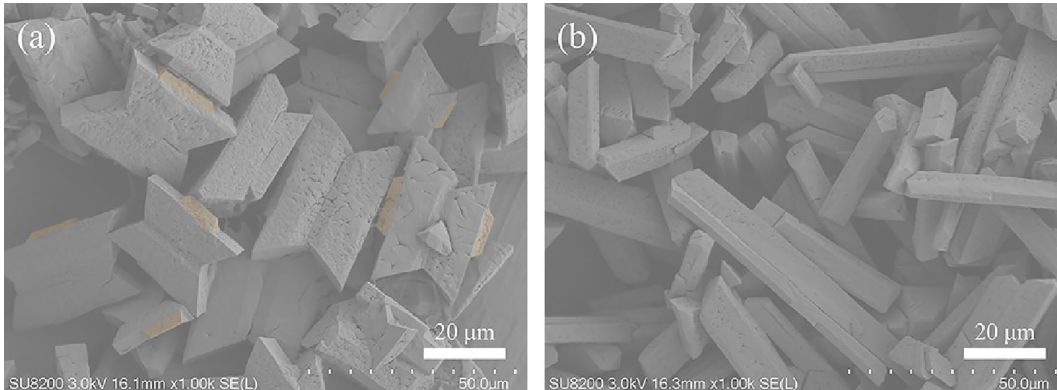
Figure 4. FESEM images of the samples biomimetically synthesized for 30 min with the macromolecule ( a ) or LMW component ( b ) separated from the supernatant.